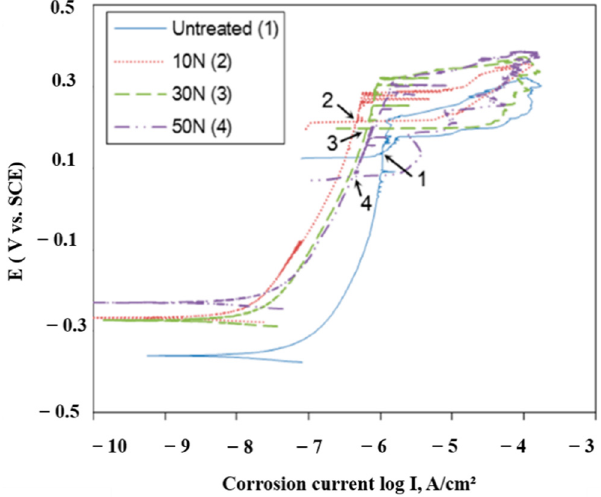
Figure 16. The cyclic potentiodynamic polarization curves obtained from USNM Ni 690 alloy subjected to 10 N, 30 N, and 50 N static loads. Reprinted with permission from ref. [112]. Copyright 2019, MDPI.